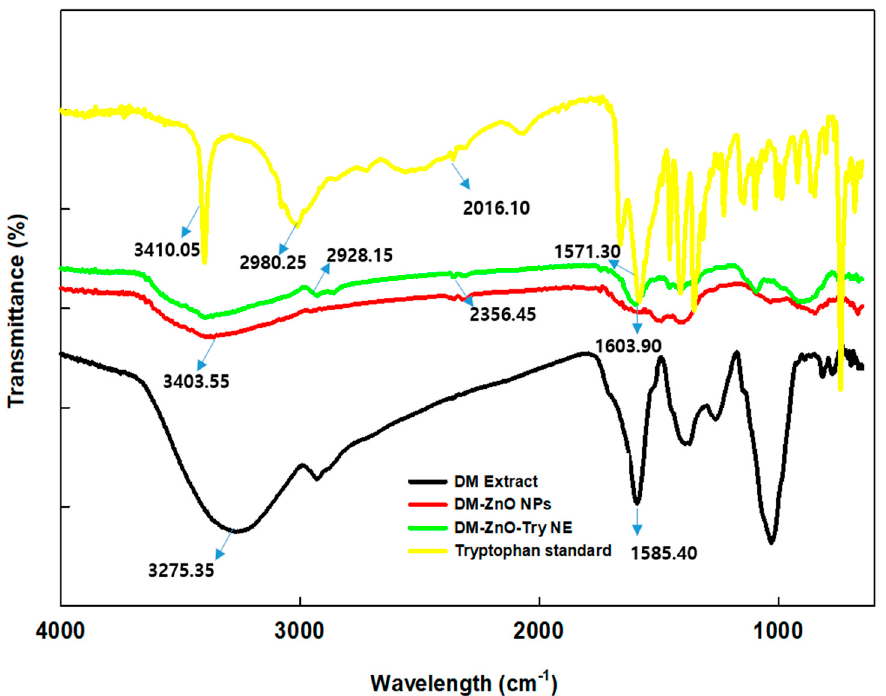
Figure 3. FT IR spectra of tryptophan standard (yellow), DM-ZnO NPs (Red), DM-ZnO-Try NE (Green), and DM plant extract (Black).